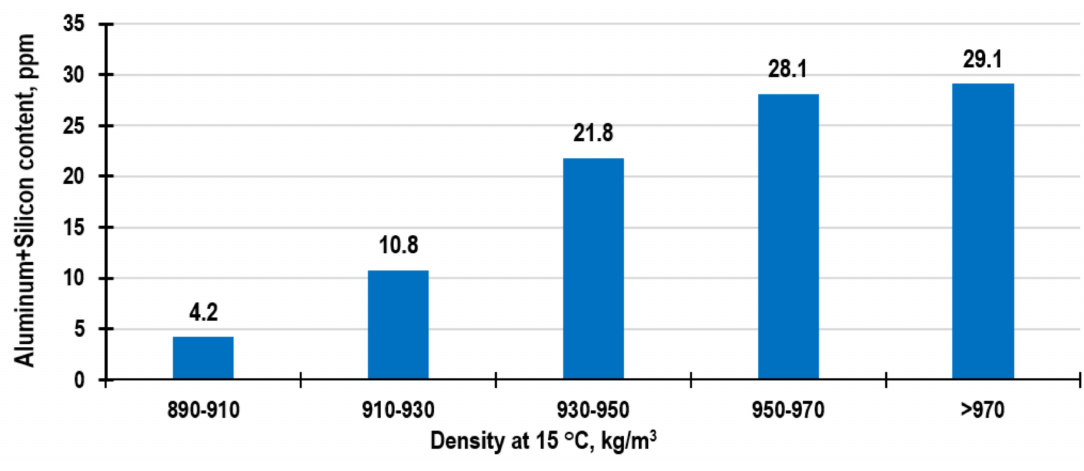
Figure 5. Aluminum plus silicon content depending on fuel density [47].